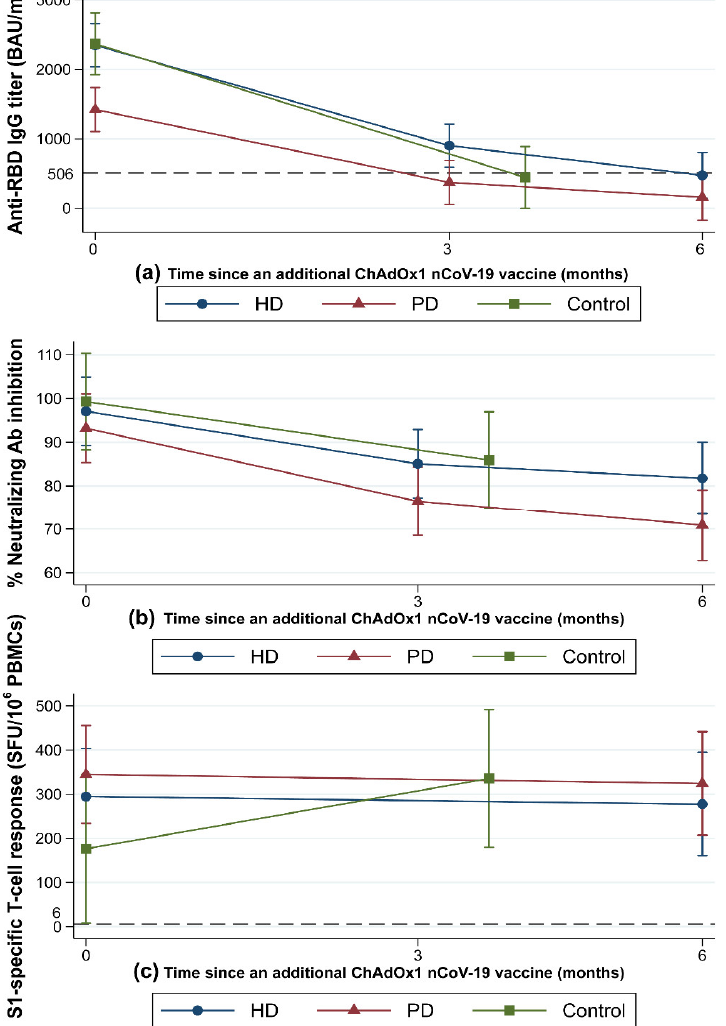
Figure 2. Dynamic changes in immunity following COVID-19 vaccination with an extended primary series. Patients undergoing HD (blue solid line) or PD (red solid line) and control participants (green solid line) were vaccinated with a heterologous inactivated SARS-CoV-2 prime-boost and then received a dose of ChAdOx1 nCoV-19. Dynamic changes in immunity were monitored from baseline (n = 57 for dialysis patients and 14 for controls) to 3 months (n = 57 for dialysis patients and 14 for controls) and 6 months (n = 50 for dialysis patients) after the third dose. ( a ) Geometric mean titers (error bars indicate the 95% CIs) of the anti-RBD IgG against the SARS-CoV-2 spike protein. The dashed line indicates the 506 BAU/mL cutoff value. ( b ) Geometric mean (error bars indicate the 95% CIs) of percent neutralizing antibody inhibition as measured by surrogate viral neutralization test. ( c ) Geometric mean (error bars indicate the 95% CIs) of IFN- γ -producing T-cell response to the S1 scanning peptide pool. The dashed line indicates the 6 SFU/10 6 PBMCs cutoff value. A b, antibody; BAU, binding antibody units; CI, confidence interval; HD, hemodialyzed patients; IgG, immunoglobulin G; PBMCs, peripheral blood mononuclear cells; PD, peritoneal dialyzed patients; RBD, receptor-binding domain; S1, S1 domain of the spike protein; SFU, spot-forming unit; SARS- CoV-2, severe acute respiratory syndrome